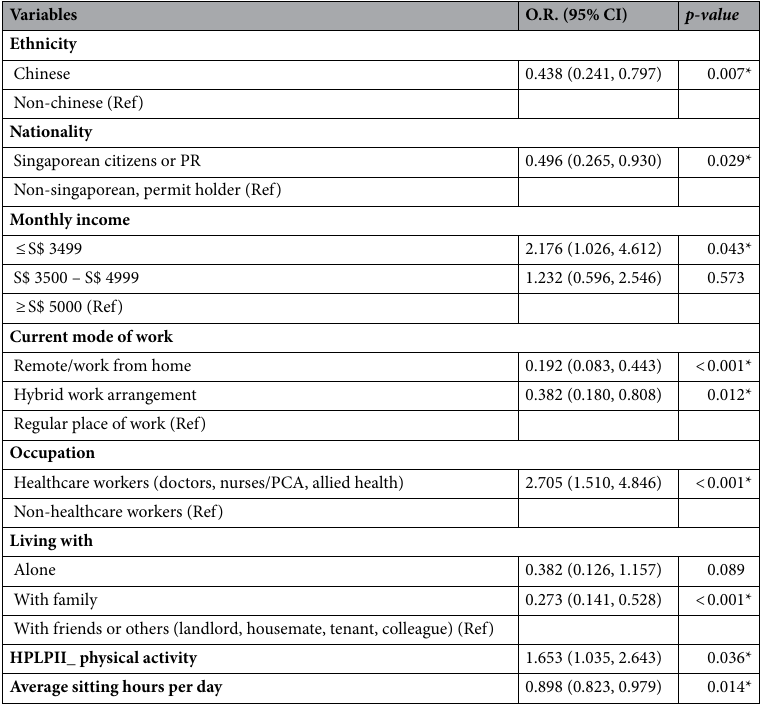
Table 4. Significant factors associated with a high level of PA in the univariate analysis.